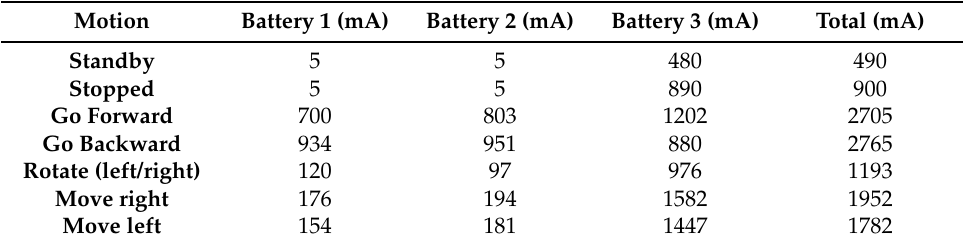
Table 2. Average electrical current of the batteries when performing different predefined motions.